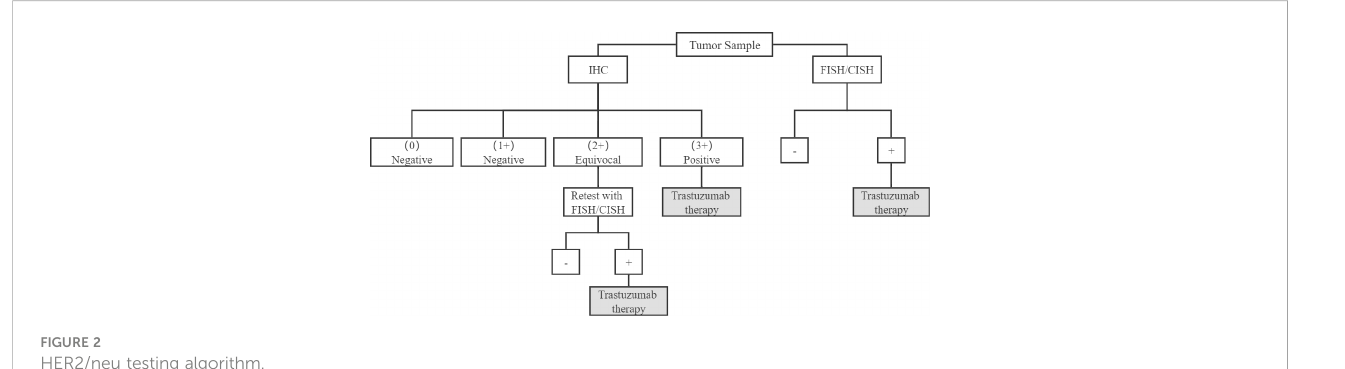
FIGURE 2 HER2/neu testing